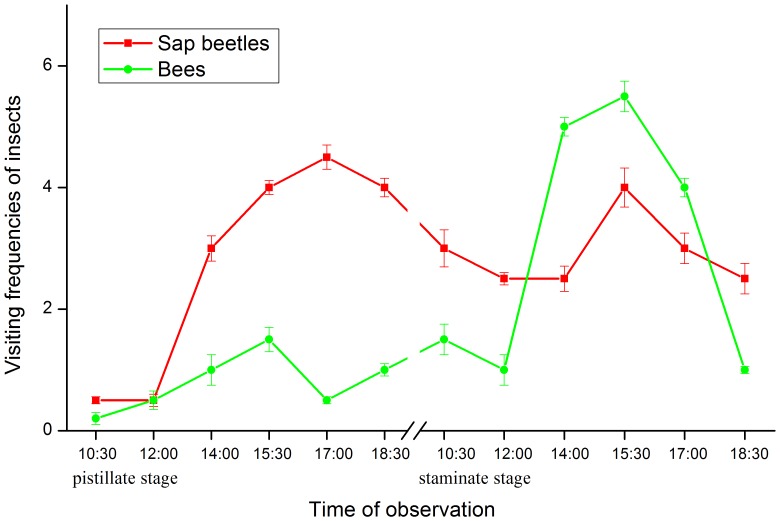
Visiting frequencies of sap beetles and bees on Magnolia sprengeri flowers at pistillate and staminate stages.The observation was conducted on 6 flowers. Sap beetles and bees landing on the observed flowers for half an hour were recorded at an interval of 1.5